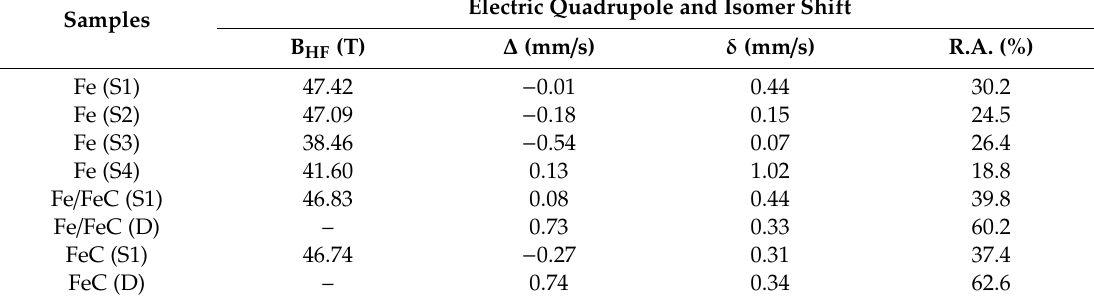
Table 3. Mössbauer parameters obtained from refinements of the spectra at 77 K. Electric quadrupole splitting ( Δ ), isomer shift ( δ ), hyperfine magnetic field (B HF ) and Relative spectral area (R.A) parameters of the Fe-containing samples. The letter S represents the sextets in the samples.